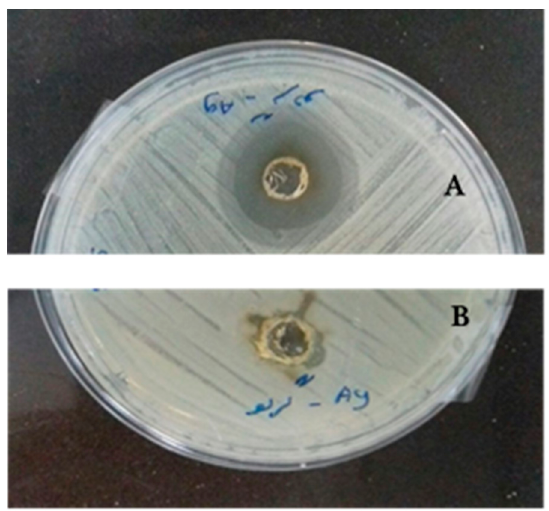
Figure 7. Created zones of inhibition with S. aureus ( A ) and E. coli ( B ) incubated at 37 °C for 24 h for synthesized Ag NPs using J. regia leaf